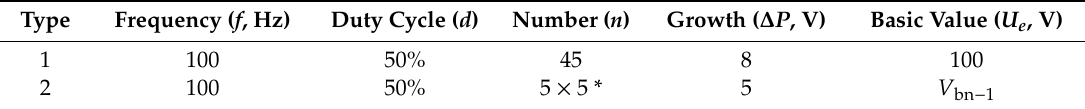
Figure 1. Process control method: ( a ) Self-adaptive control model, ( b ) self-adaptive control process, and ( c ) feature information identification algorithm. Table 1. Parameters obtained during the test pulses experiment.